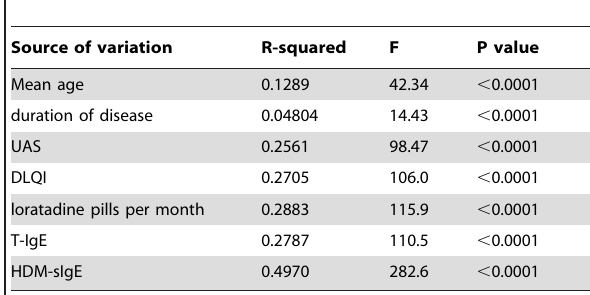
Table 2. One-way analysis of variances of clinical and laboratory data among different subgroups based on the result of ASST and